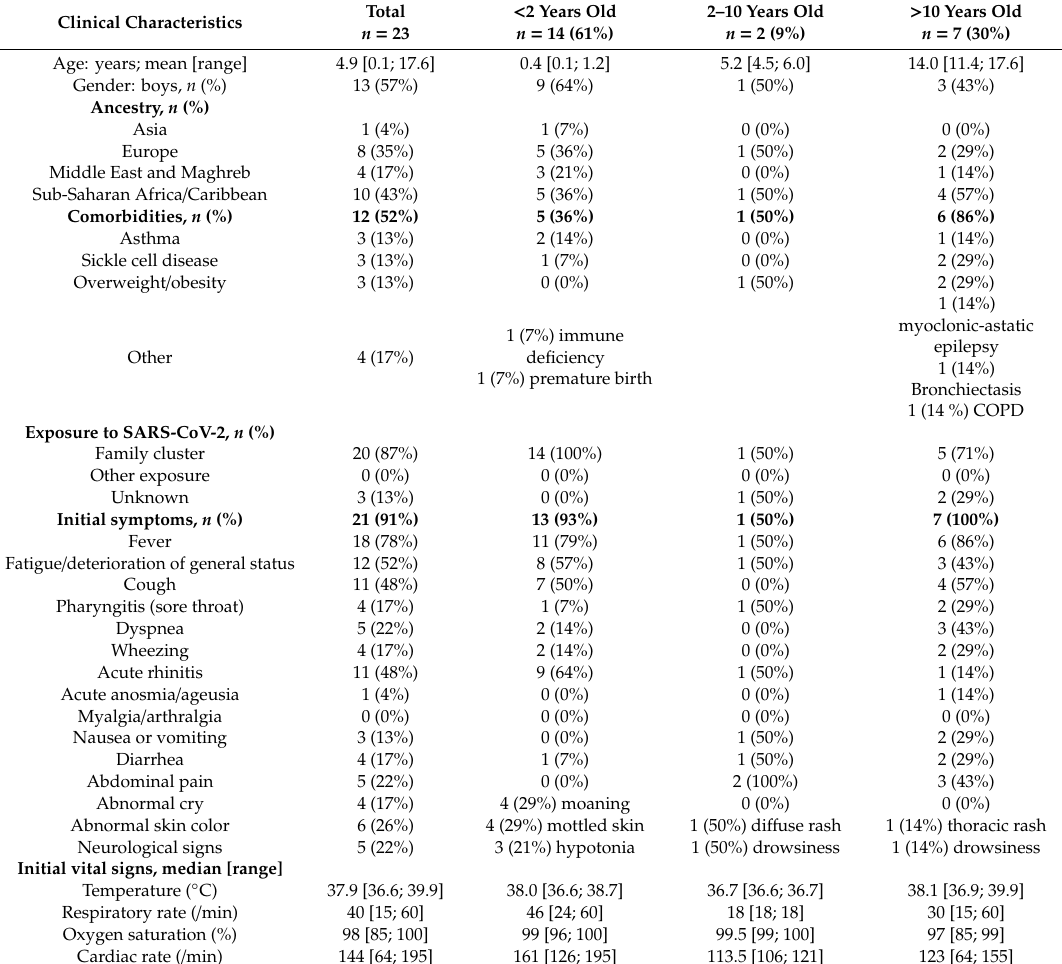
Abbreviations: COPD: chronic obstructive pulmonary disease. Sub-section headings are indicated in